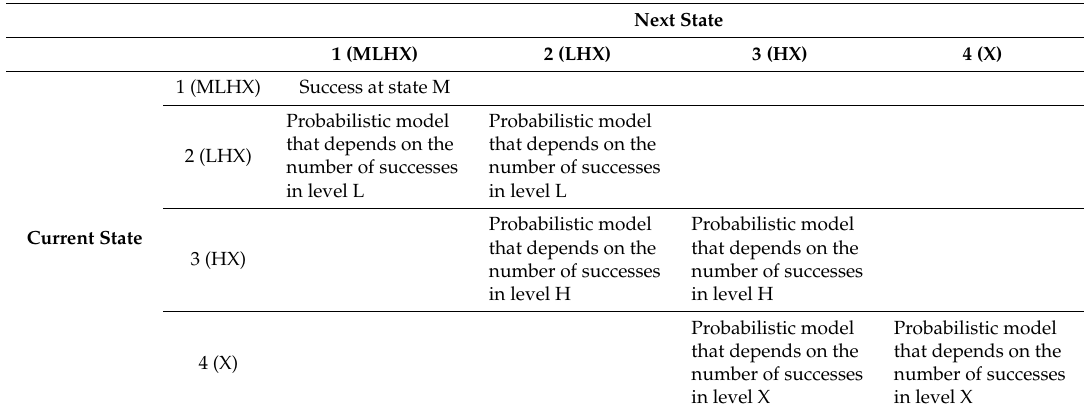
Table 3. State transition matrix when state levels go down [12,13].